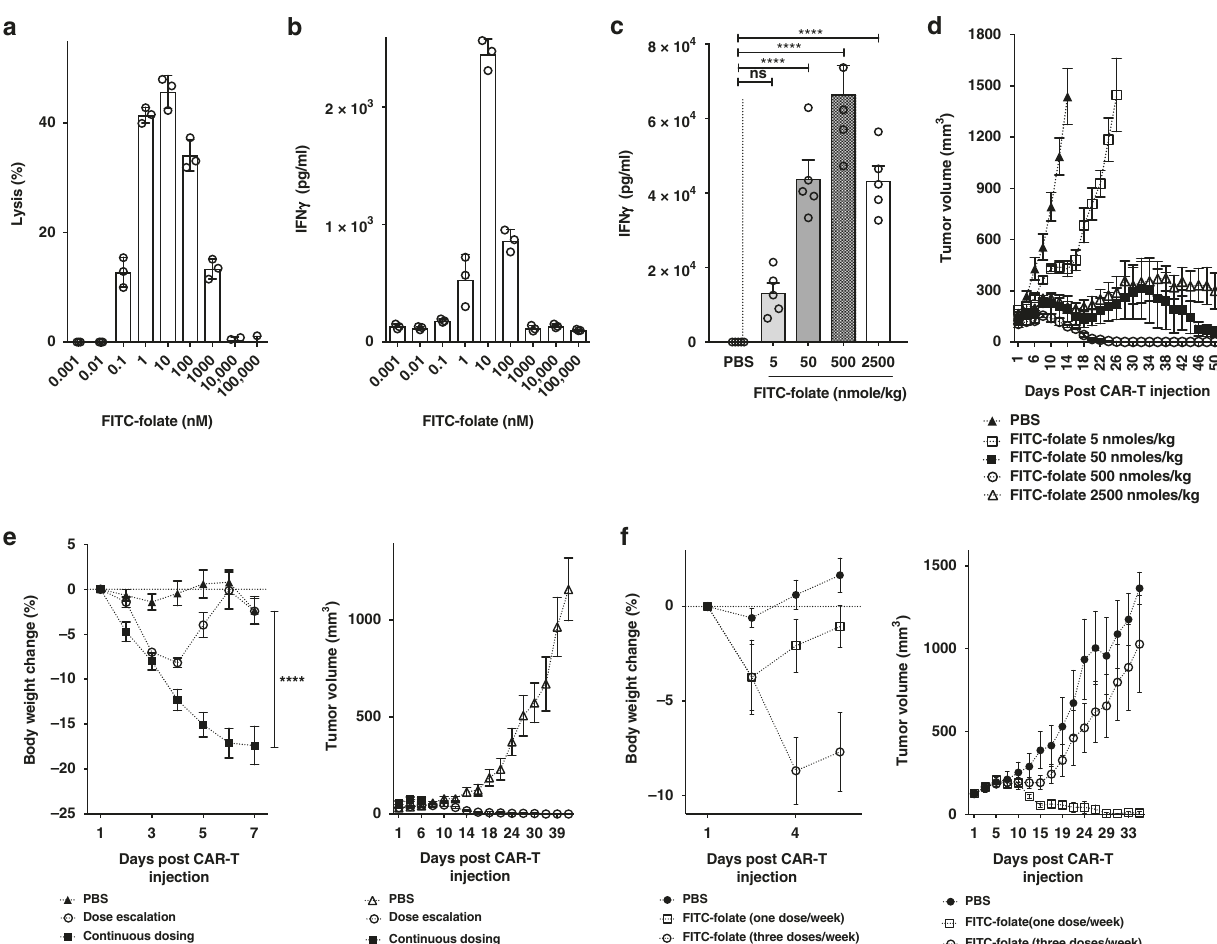
Fig. 6 Prevention of CRS by gradual escalation of adapter dose or decrease in adapter dosing frequency. a – d Effect of adapter concentration on the regulation of cytokine release and anti-tumor activity in vitro and in vivo. a Lysis of MDA-MB-231 cells in culture by anti- fl uorescein CAR T cells (5:1 = effector:tumor cell ratio) in the presence of various concentrations of FITC-folate (0.001 nM to 100 μ M). b IFN γ release from cells described in ( a ). c The level of IFN γ in the plasma of MDA-MB-231 tumor-bearing mice 6 days after initiation of therapy by injection of 15 × 10 6 CAR T cells. Mice were treated with 5, 50, 500, or 2500 nmole/kg FITC-folate on days 1, 2, 8, 10 and alternate days thereafter (treatments on days 4 and 6 were omitted to avoid a CRS). d Analysis of tumor growth in treatment groups of panel c . e Measurement of body weight change and tumor volume in MDA-MB-231 tumor-bearing mice treated with 15 × 10 6 CAR T cells plus (1) PBS only, (2) gradually escalating dose of FITC-folate (0.5 nmole/kg on days 1 and 2, 5 nmole/kg on days 4 and 6, 50 nmole/kg on days 8 and 10, and 500 nmole/kg from day 12 onward), or (3) constant dose of 500 nmole/kg FITC-folate on alternate days. f Measurement of body weight change and tumor volume in MDA-MB-231 tumor-bearing mice treated with 5 × 10 6 CAR T cells on day 1 plus either PBS or FITC-folate (500 nmole/kg) on day 1, or alternatively on days 1, 3, and 5. n = 5 mice per group. All data represent mean ± s.e.m. One-way ANOVA with either post-hoc Dunnett ( c ) or Tukey tests ( e ) were performed (*denotes a p -value < 0.05, ** < 0.01, *** < 0.001, **** < 0.0001, ns = not signi fi